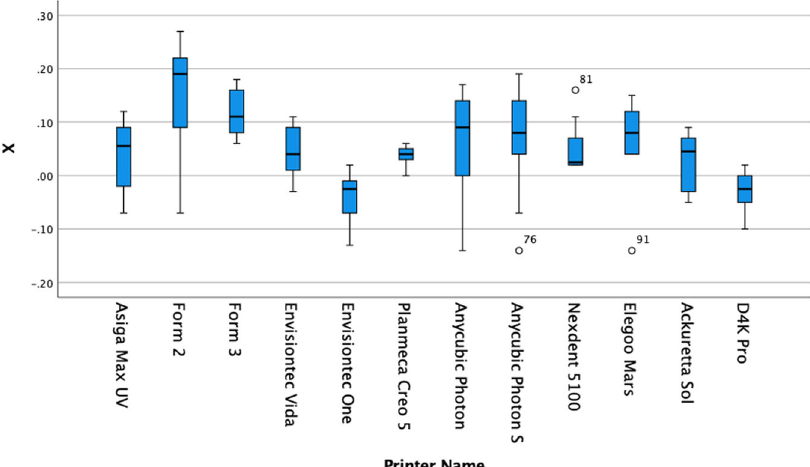
Fig. 3 Box plot of X data set for each printer in the present study. The distribution of numerical data of the measurements of the X dimension for each print and skewness through displaying the data quartiles and averages. The y-axis show the numerical data in terms of deviation from the actual size in microns and the x-axis labels each data set in terms of which printer it applies to.